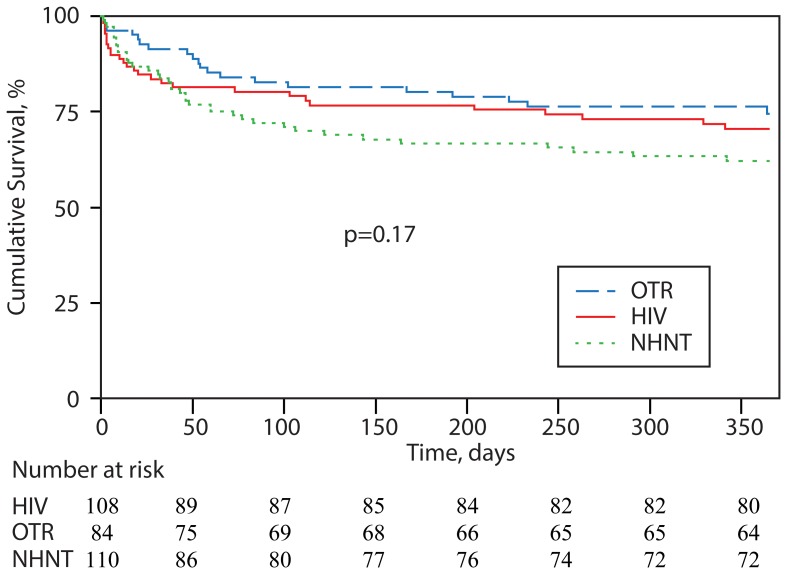
Kaplan-Meier survival curve of HIV-positive patients, OTRs, and NHNT patients among 302 patients with cryptococcosis at UAB, 1996–2010.Non-HIV, non-transplant patients had the lowest survival, but the difference across groups did not reach statistical significance. Note. HIV, human immunodeficiency virus; OTRs, organ transplant recipients; NHNT, non-HIV, non-transplant.